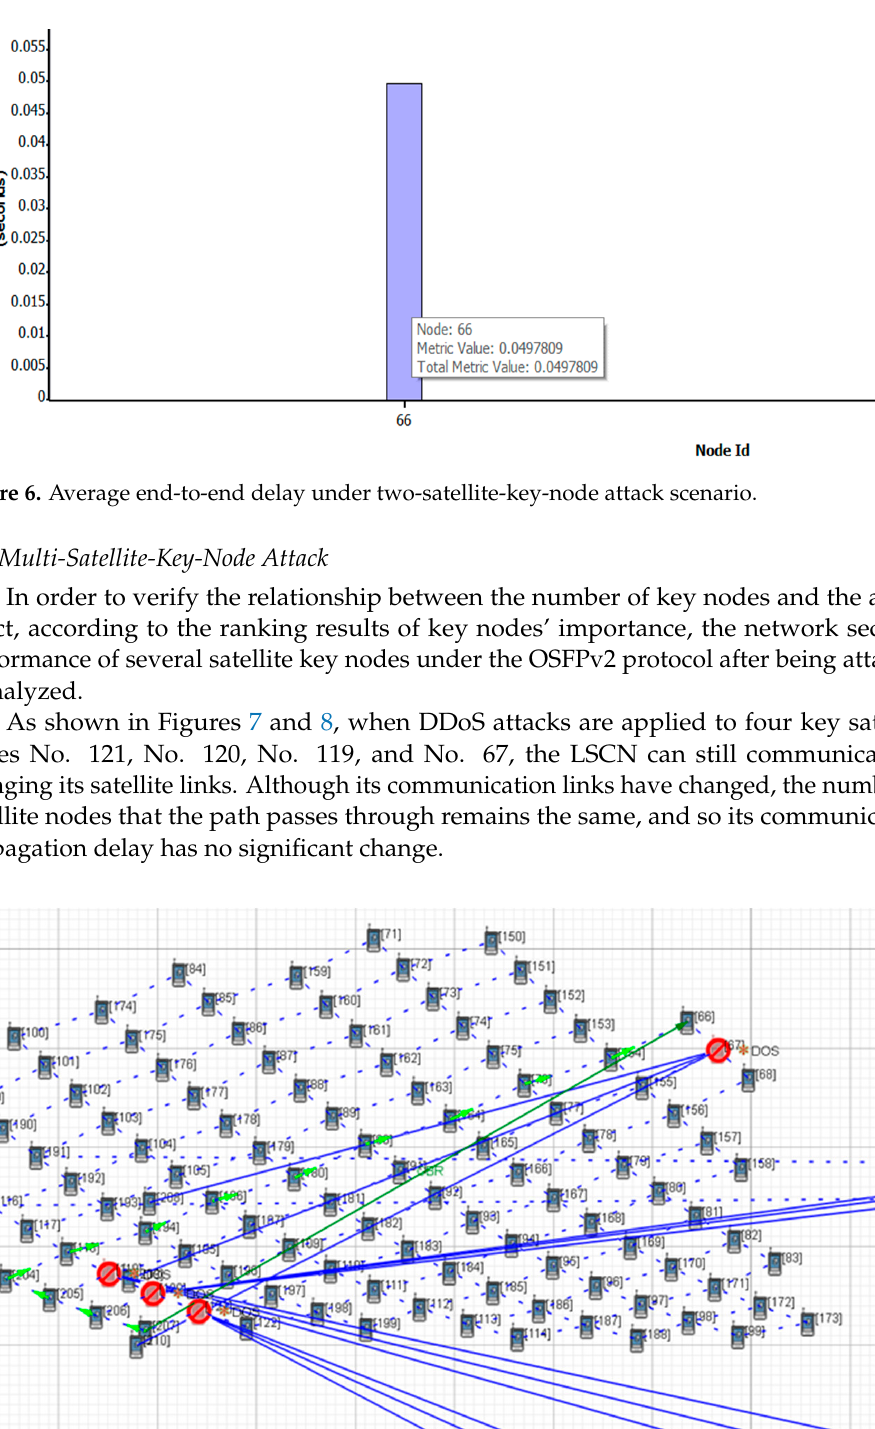
Figure 5. Two–satellite–key–node attack scenario under Bellman–Ford protocol.